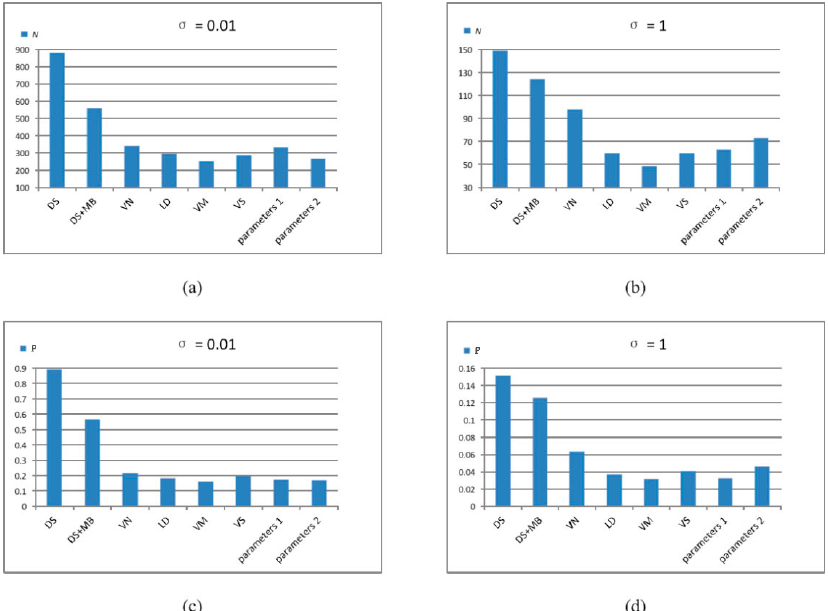
Figure 7. Evaluations of fusion effects of white building pictures in two experiments ( DS (directly seamed); MB (multi-band blending)). ( a ) N with σ = 0.01, ( b ) N with σ = 1, ( c ) P with σ = 0.01, and ( d ) P with σ = 1.